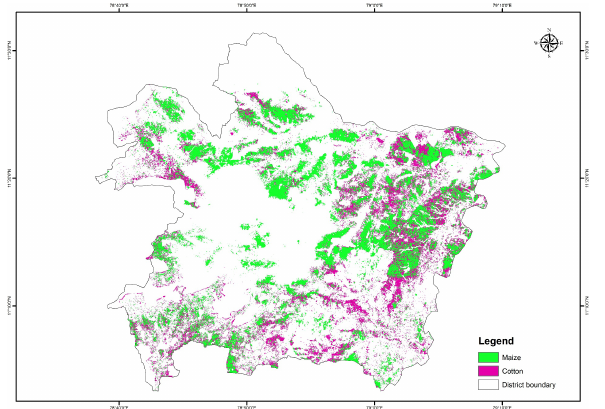
Figure 10. Classified image using unsupervised classification